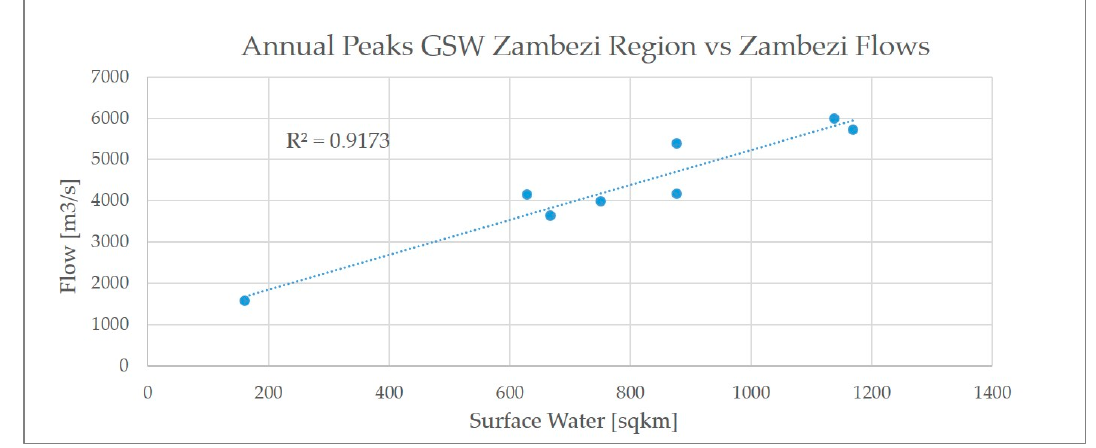
Figure 10. Comparison of surface water and water flows annual peaks between 2008 and 2015.